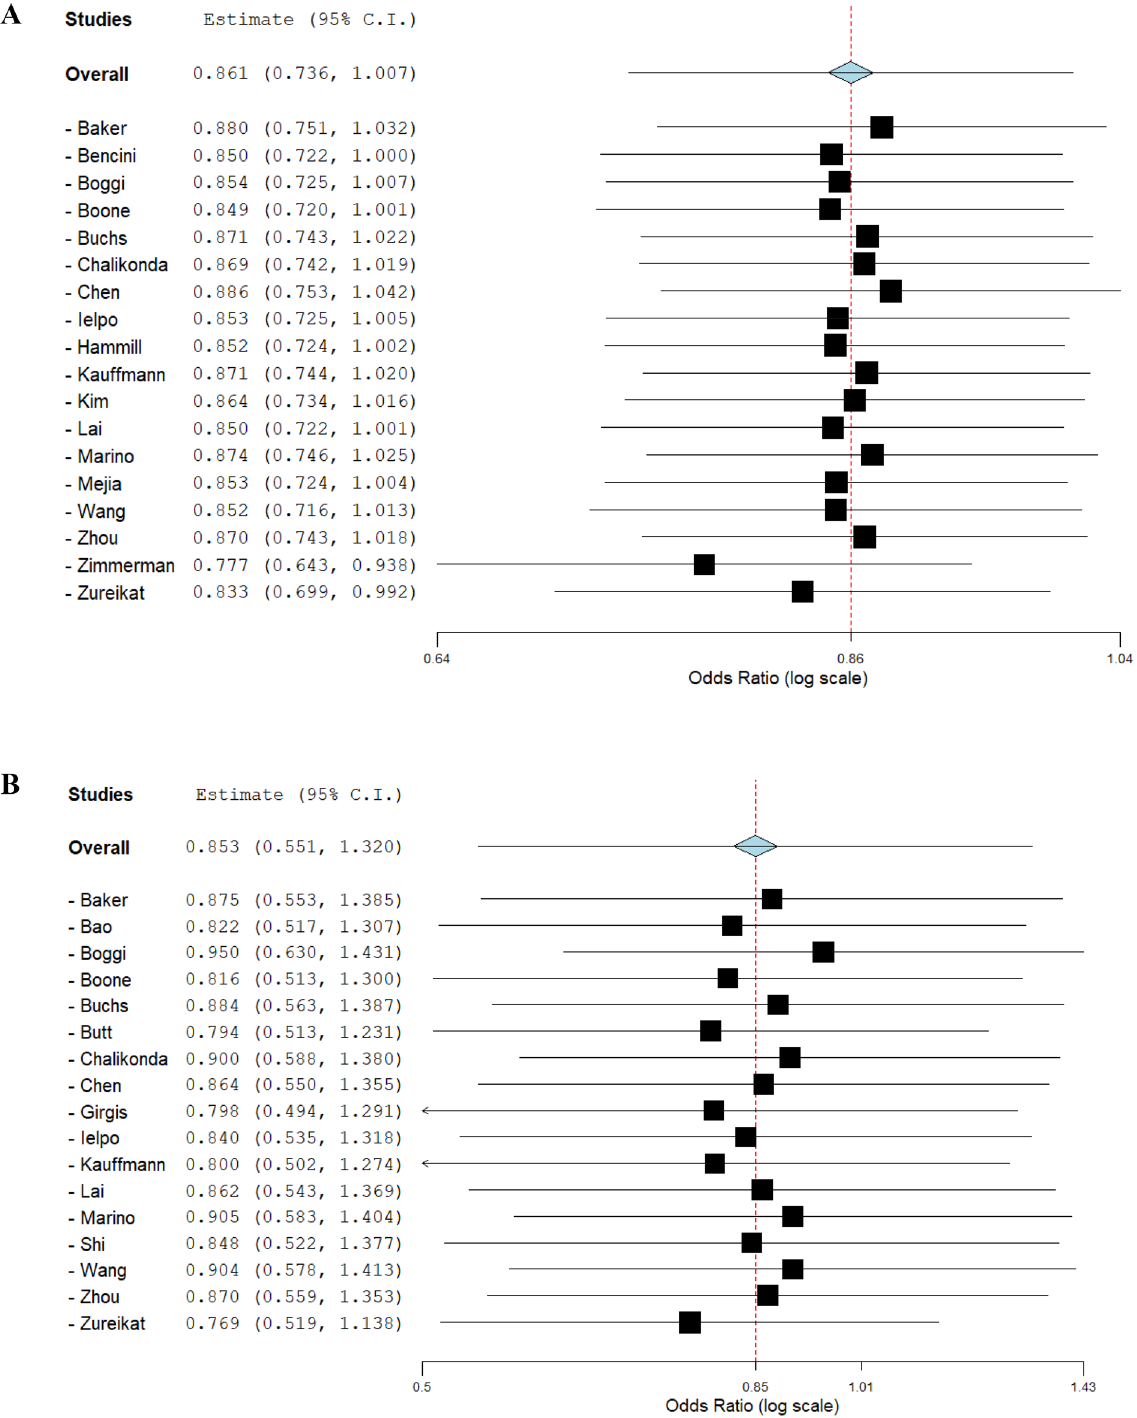
Figure 8. Sensitivity analysis: ( A ) Leave-one-out meta-analysis of overall postoperative morbidity. ( B ) Leave- one-out meta-analysis of margin involvement